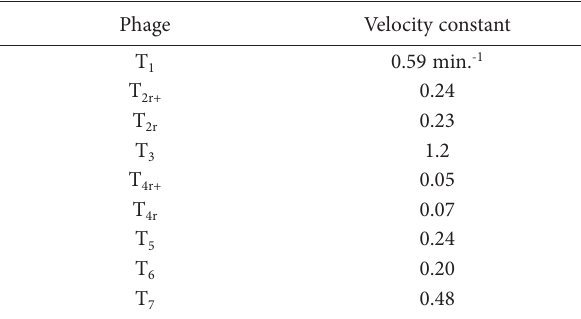
Table II . The Average Velocity Constants for the Shaking Inactiva- tion of coli Phages at 26°C. and pH